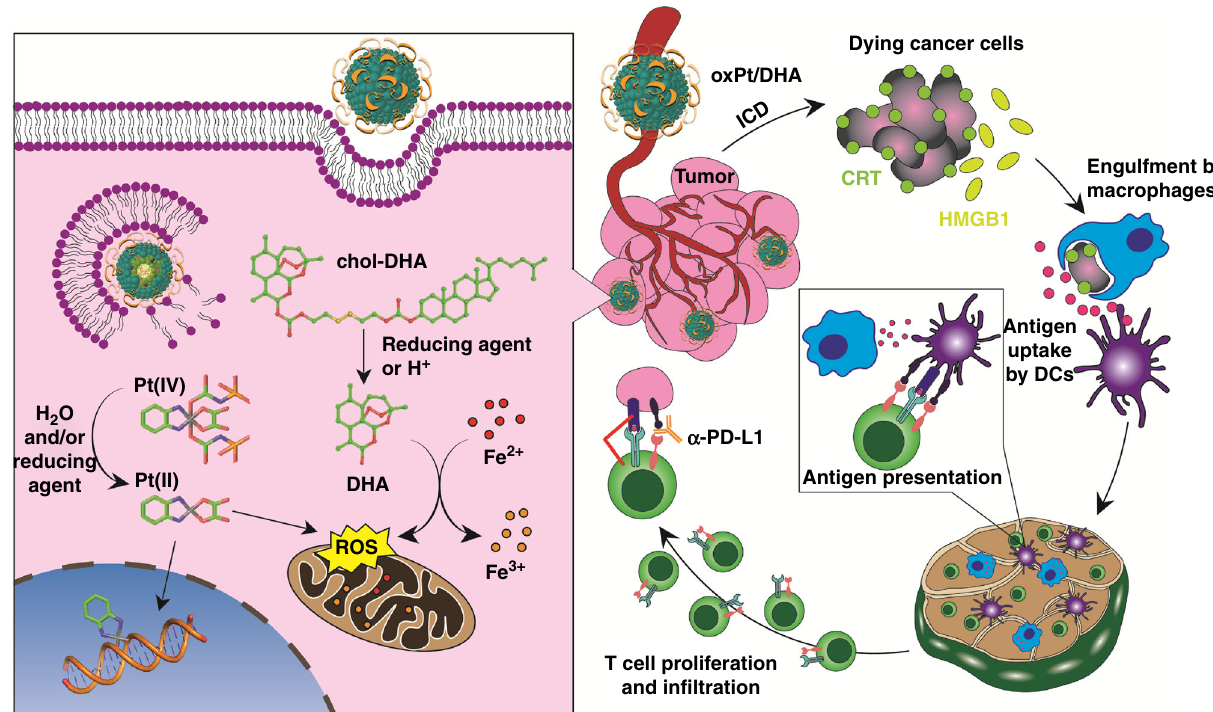
Fig. 9 Anticancer and immune mechanisms of OxPt/DHA. left, The disruption of the lipid bilayer of OxPt/DHA upon endocytosis exposes the chol-DHA and OxPt prodrugs to triggered release by hydrolysis and/or reduction. The resultant parent drugs exhibit the expected mechanisms of action of DNA adduct formation and/or ROS generation. right, Systemically delivered OxPt/DHA can accumulate in the tumours and release the drug payload, as shown on the left, for immunogenic cell death of the cancer cells. Cell-surface CRT expression and release of DAMPs, such as HMGB1, lead to phagocytosis by macrophages and/or dendritic cells, which travel to the regional lymph node to prime T cells. Macrophages can release the antigens for DC uptake and subsequent T cell activation. The tumour-speci fi c T cells proliferate and in fi ltrate into the tumour, where they can exert their cytotoxic effects. The α -PD-L1 prevents the binding of tumour PD-L1 and T cell PD-1, thereby inhibiting deactivation of the T